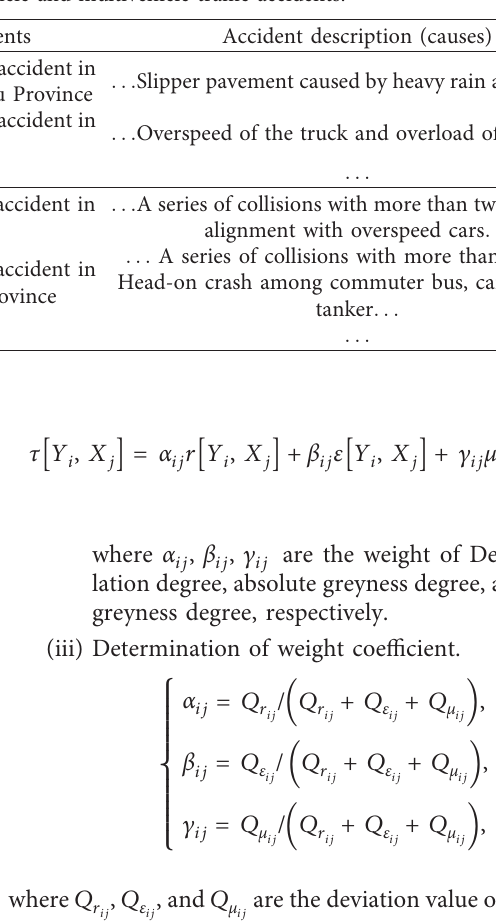
Table 2: Sample raw data for single-vehicle and multivehicle traffic